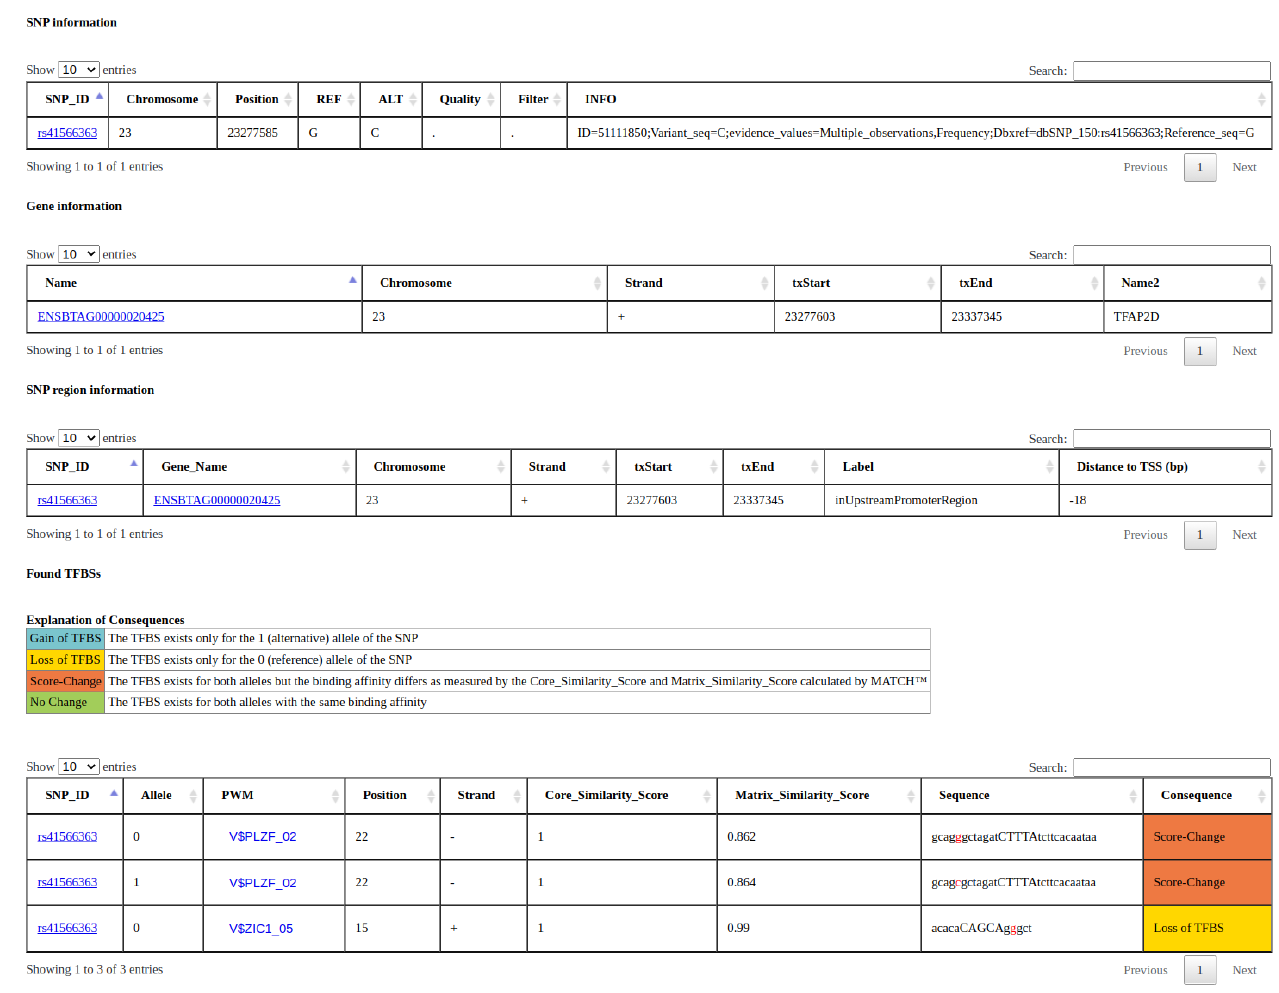
Figure 4. Example of a search result from agReg-SNPdb. The search was performed by the SNP id rs41566363 of cattle. The result tables contain, first, general SNP information; secondly, general gene information; thirdly, information about the SNP region, in particular the promoter region and distance to the TSS; and lastly, the overlapping TFBSs (represented by PWMs) for the SNP with predicted